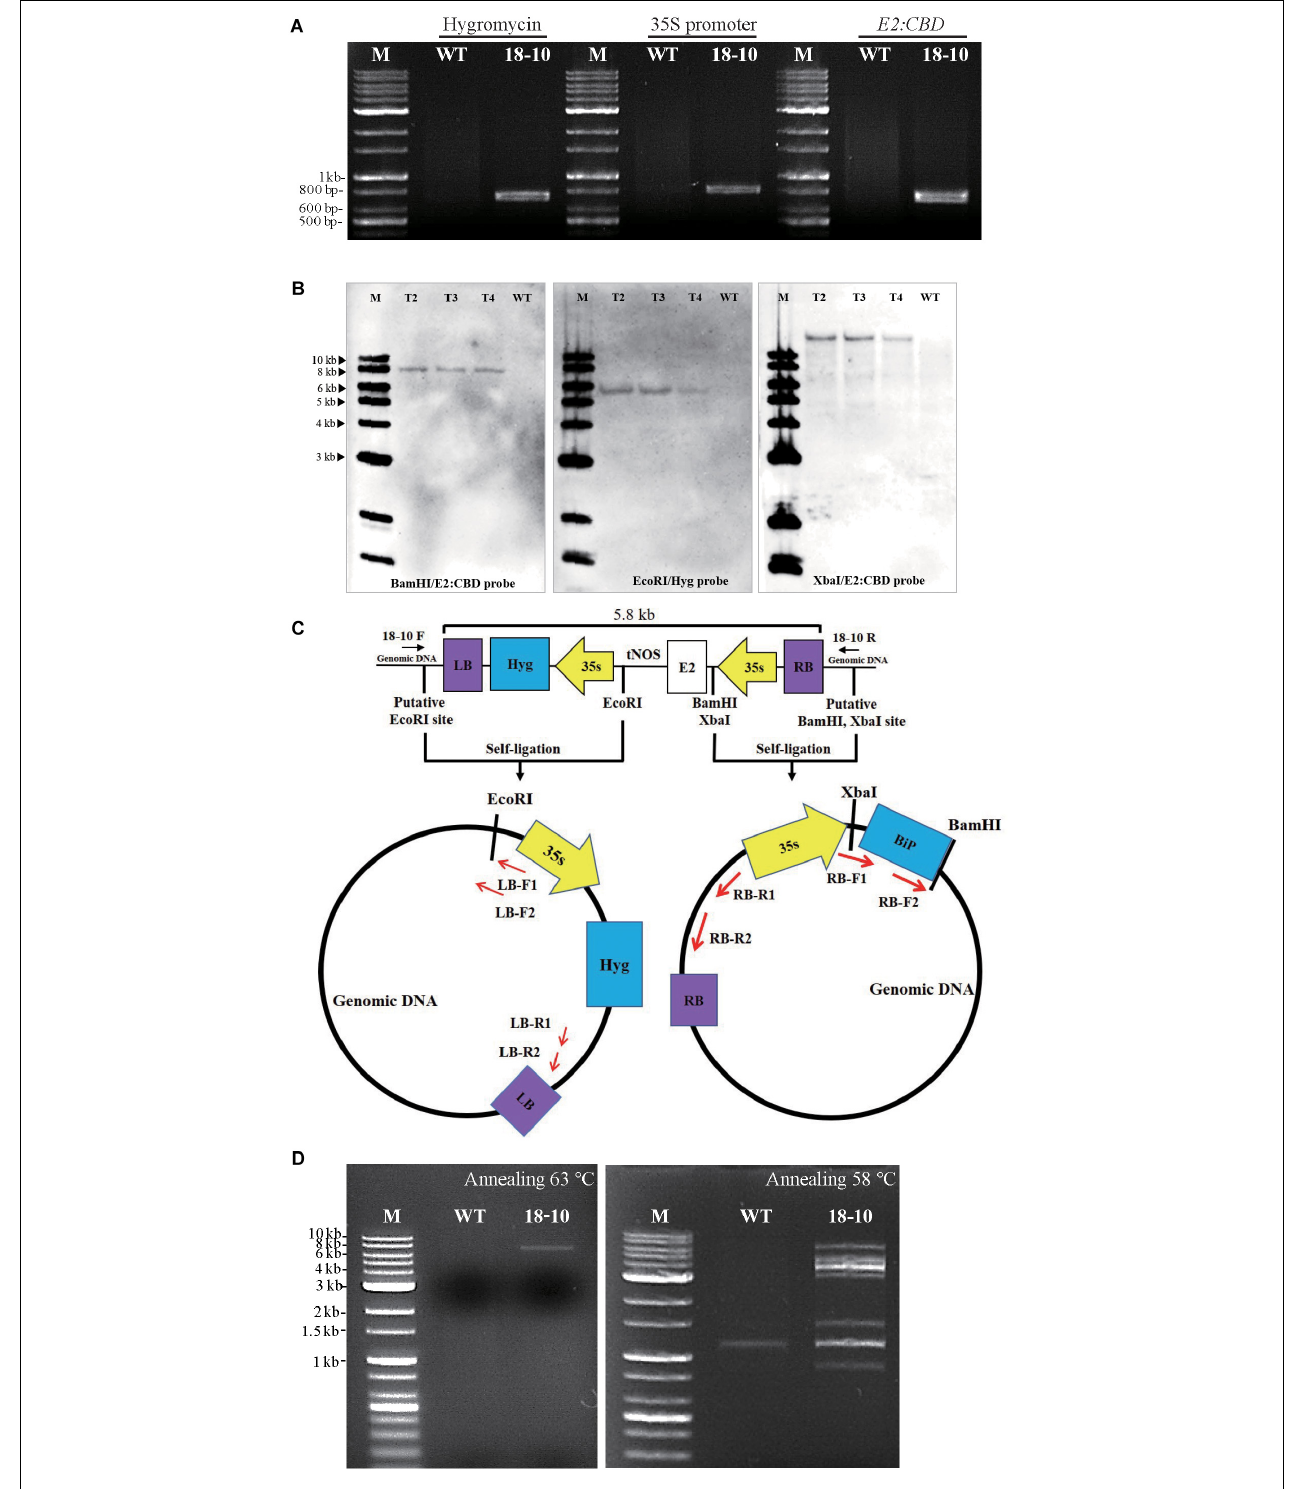
FIGURE 2 | Transgenic plant line 18–10 contains only a single-copy insertion of the MELCHE2 construct in an intergenic region. (A) PCR analysis of the T-DNA in transgenic Nicotiana benthamiana line 18–10. Genomic DNA was extracted and used for PCR amplification of hygromycin resistance gene, 35S promoter, and E2:TEV:CBD:HDEL . PCR products were analyzed by agarose-gel electrophoresis. M, DNA size markers (relevant sizes indicated to the left of the panel); WT, wild type. (B) Southern-blot analysis of transgenic line 18–10. Genomic DNA from T2, T3, and T4 generations of line 18–10 was digested with